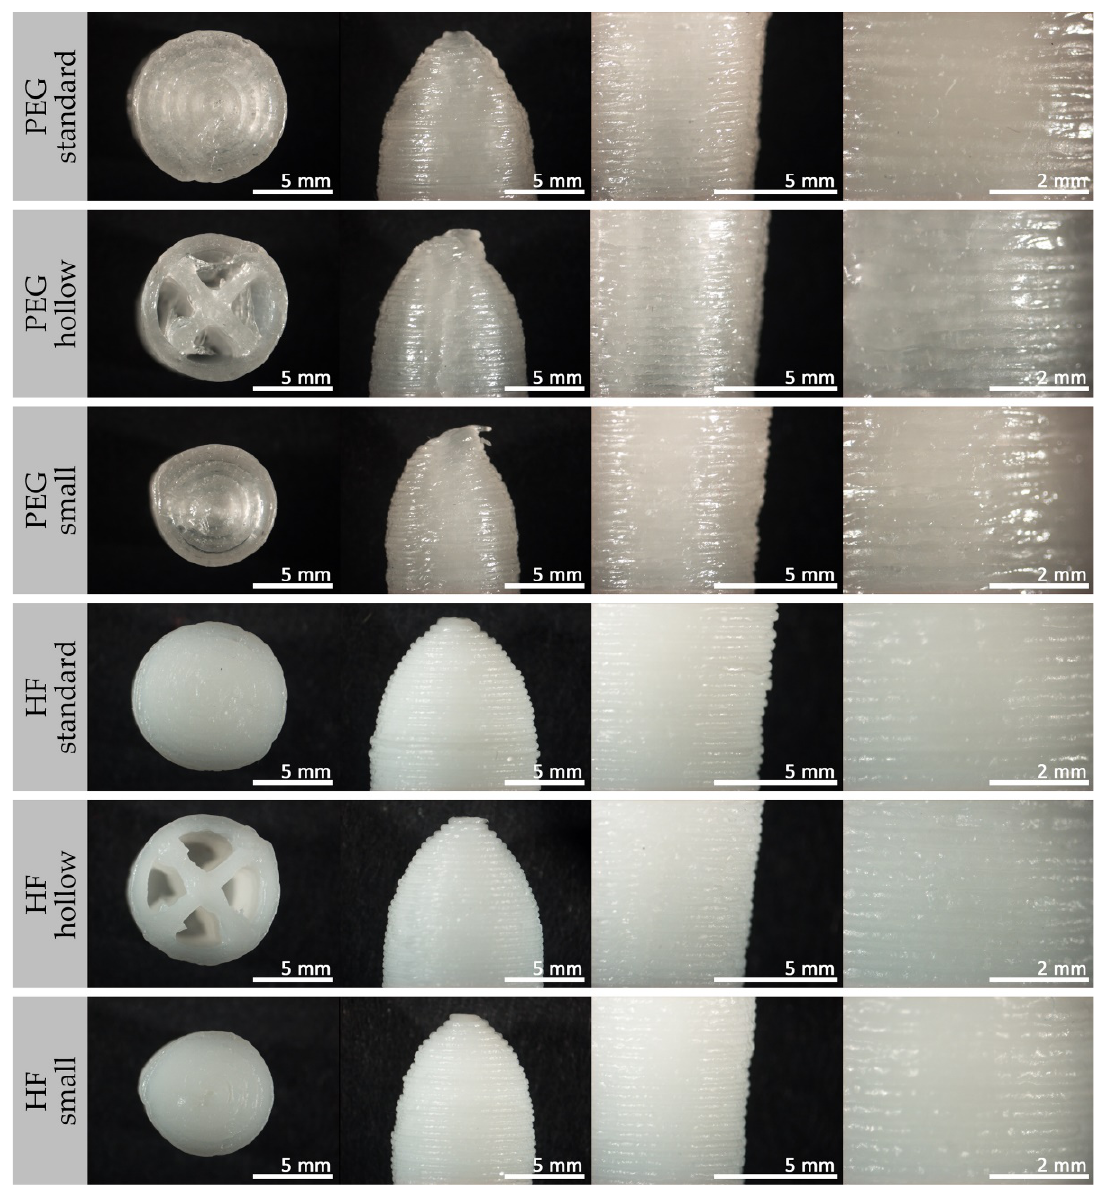
Figure 5. Microscopic images of 3D printed suppositories containing paracetamol based on PEG or HF in different printing designs.